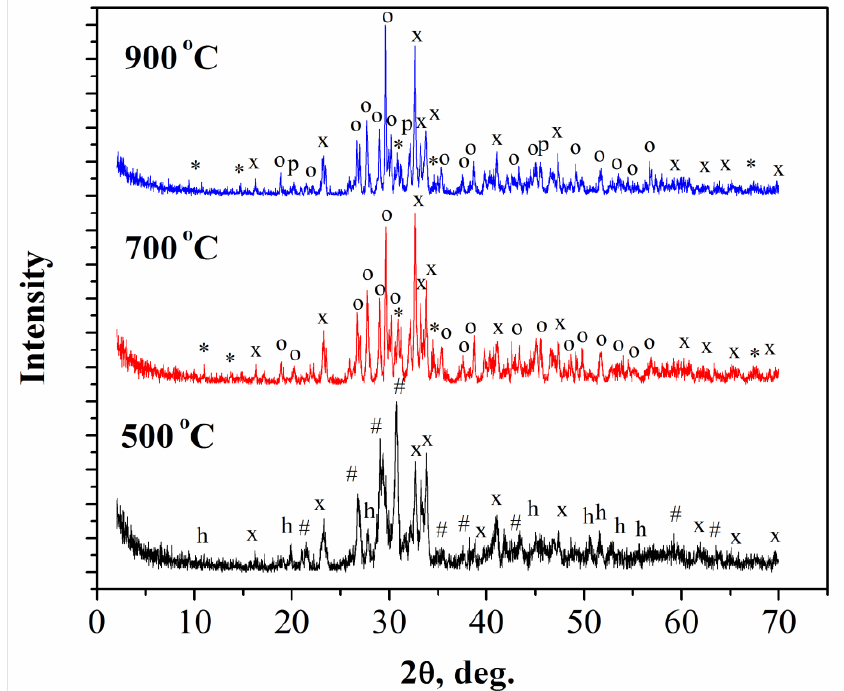
Figure 5. The XRD of ceramic samples based on cement-salt stone CaNa in the temperature range of 500 – 900 °C. h — Ca 10 (PO 4 ) 6 (OH) 2 (PDF 74 – 565), x —β -CaNaPO 4 (PDF 29 – 1193); # — ϒ -Ca 2 P 2 O 7